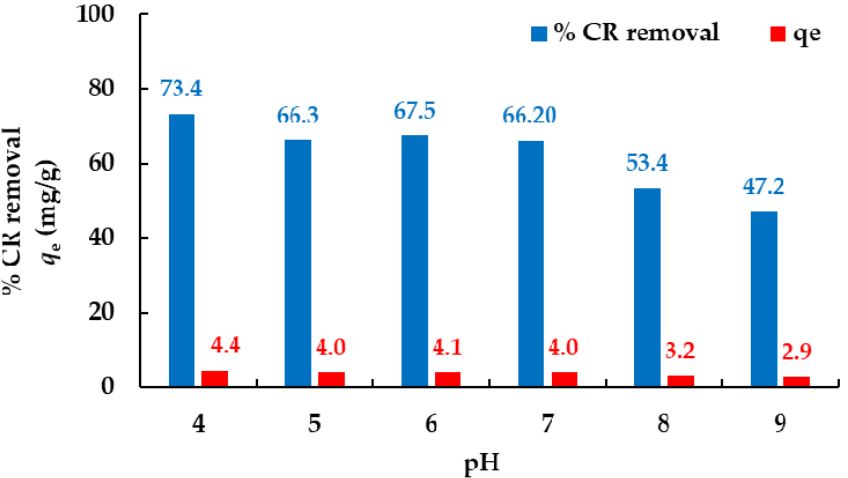
Figure 8. The effect of pH on biosorption of CR to EP ( γ CR = 50 mg dm − 3 , γ biosorbent = 8 mg dm − 3 , t = 360 min, T = 298.15 K, v = 150 rpm).